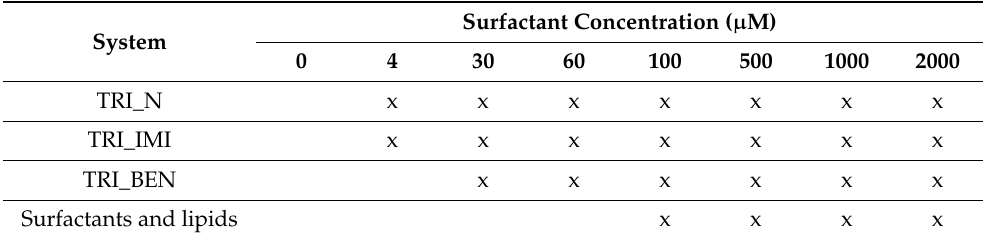
Figure 11. The results of the HeLa cells trypan blue staining after incubation with TRI_N. ( a ) Untreated cells, ( b , c ) samples with increasing concentrations of surfactant without L1, ( d ) cells treated with L1, and ( e , f ) samples with increasing concentrations of surfactant in the presence of L1. Table 4. Summary of trypan blue staining results for studied surfactants and surfactants/lipids mixtures. x—used when the most cells were blue or dark